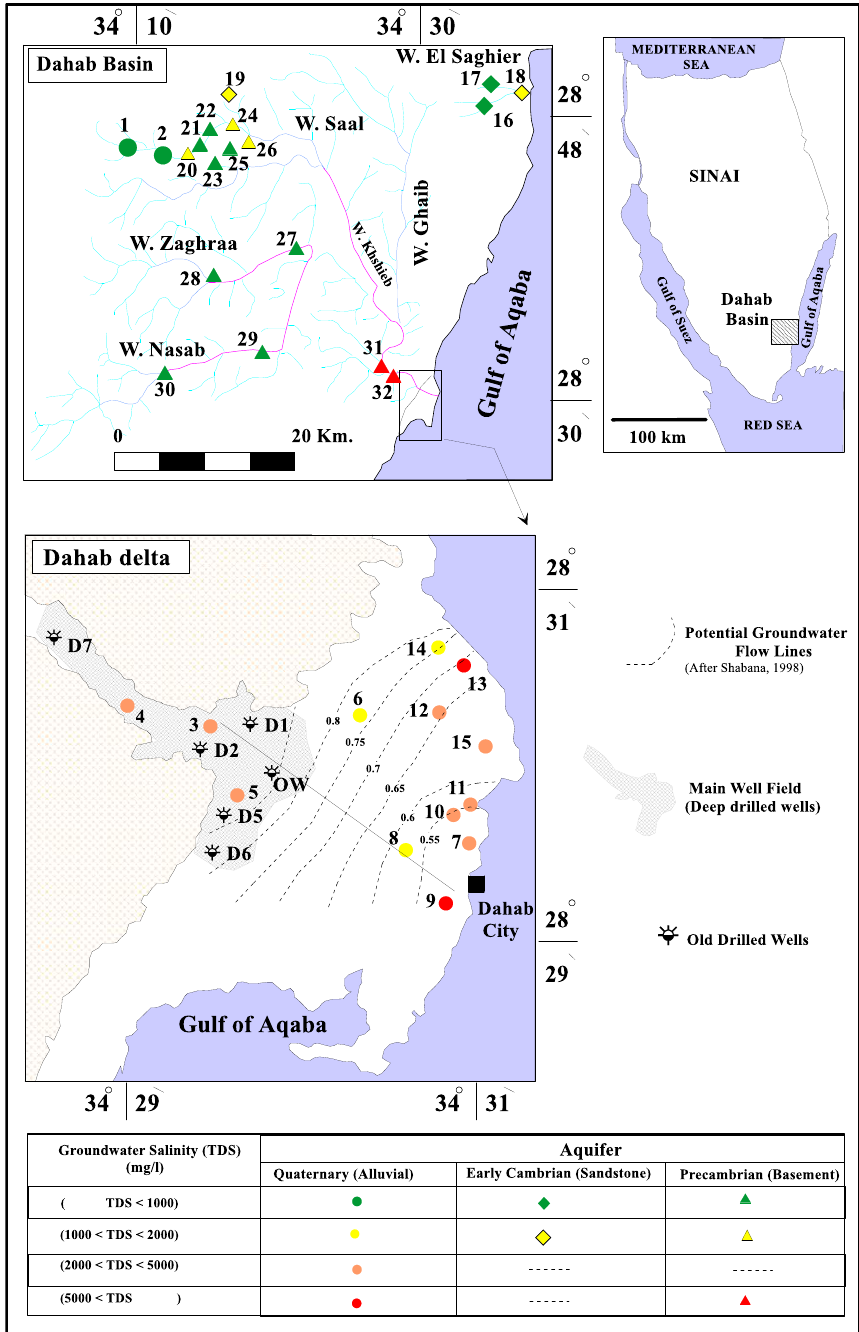
Figure 2. Location map of the Dahab basin study area.